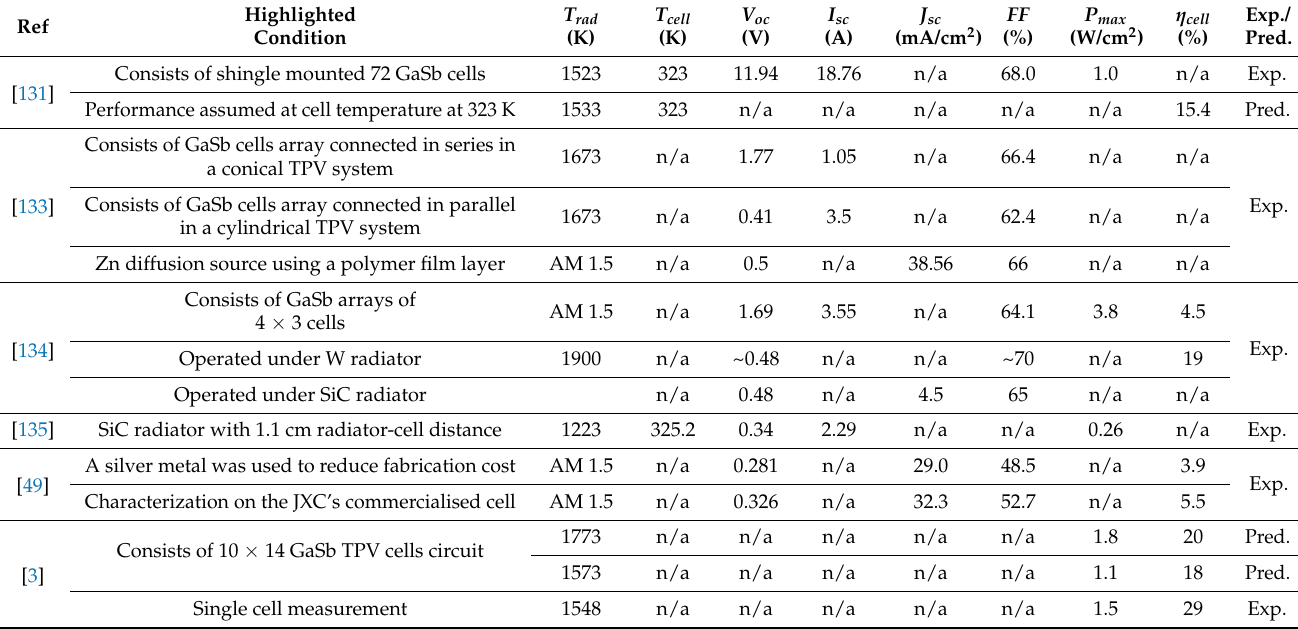
Table 2. The performance comparison of Zn-diffused GaSb TPV